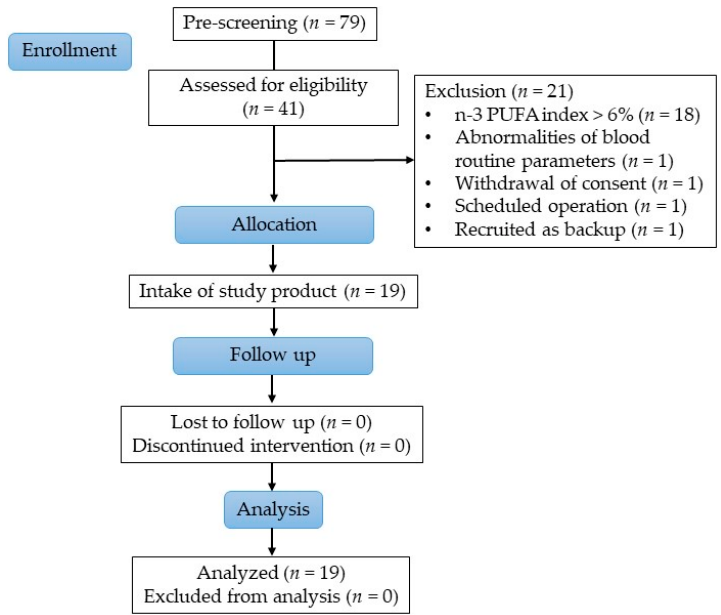
Figure 1. Study flow diagram.